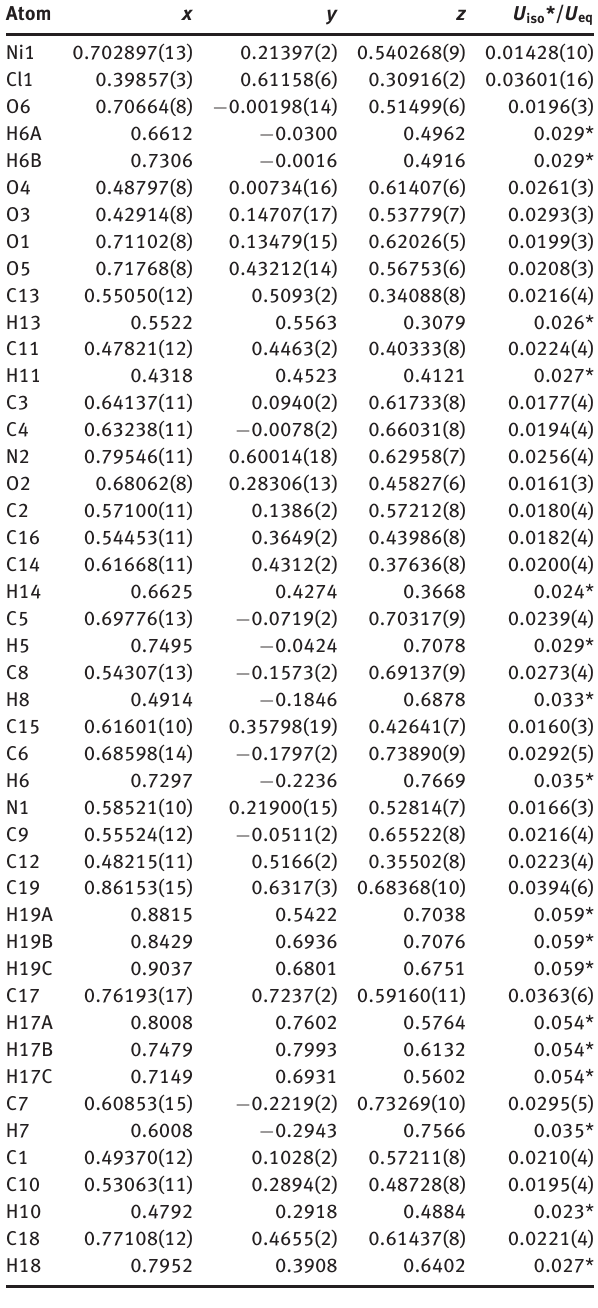
Table 2: Fractional atomic coordinates and isotropic or equivalent isotropic displacement parameters (Å 2